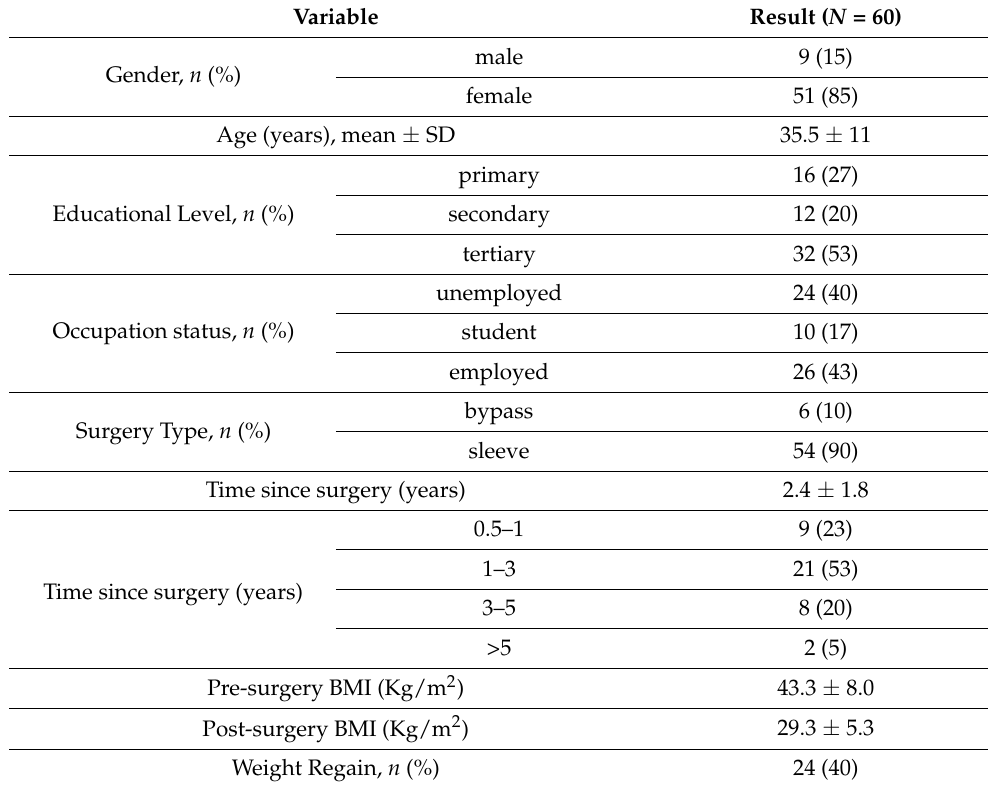
Table 1. Characteristics of the study